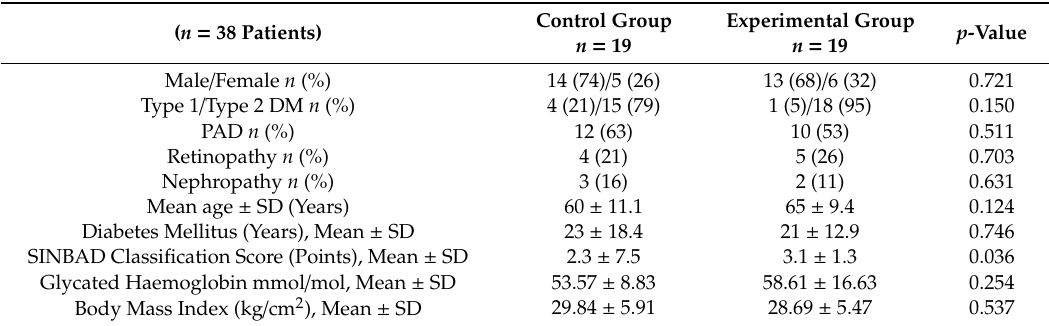
Table 2. Baseline data of the sample.